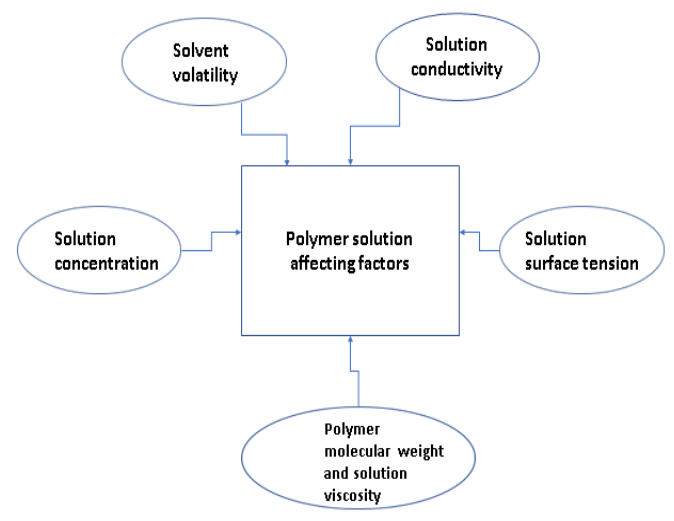
Figure 2. Polymer solution affecting